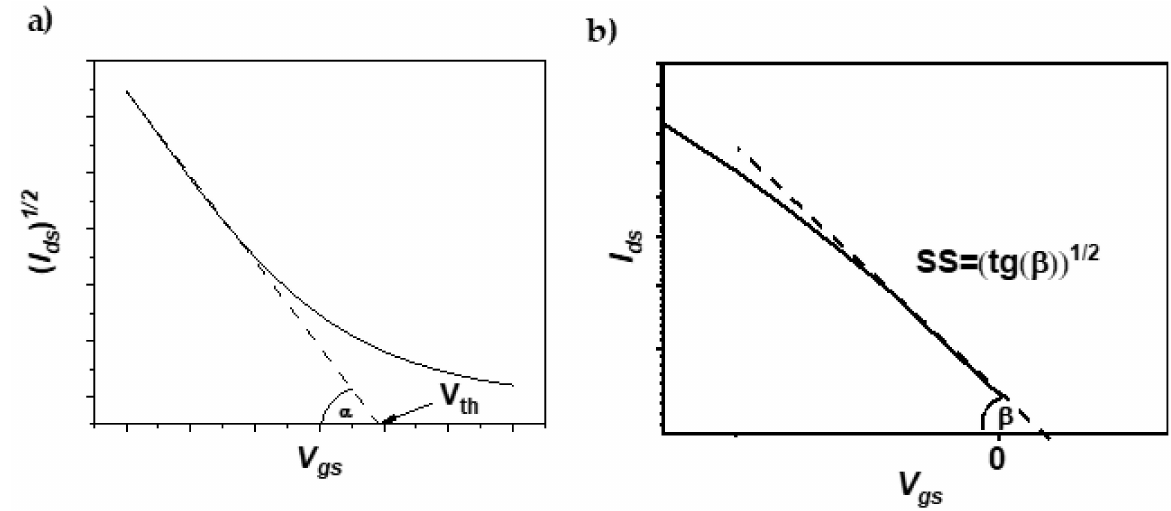
Figure 2. OFET transfer characteristics with a straight line intersecting the V gs axis at V th at the α angle fitted to the linear region of the curve ( a ); the subthreshold regime for the transfer characteristic with the line fitted to the transfer curve in half logarithmic scale ( b